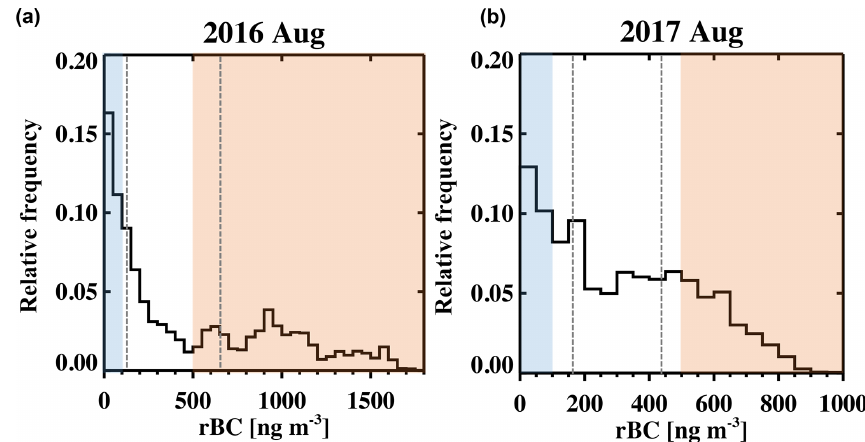
Figure 5. Histograms of 1min refractory black carbon mass concentration at Ascension Island for August 2016 (a) and 2017 (b) . Tercile values are indicated with gray dashed lines, and red and blue shadings indicate the daily thresholds selected for “more” and “less” smoky